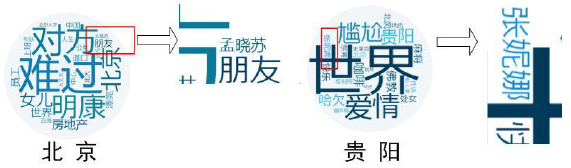
Figure 14. Tag clouds of Beijing and Guiyang on the same day Our experimental data include 33 big cities in China in a